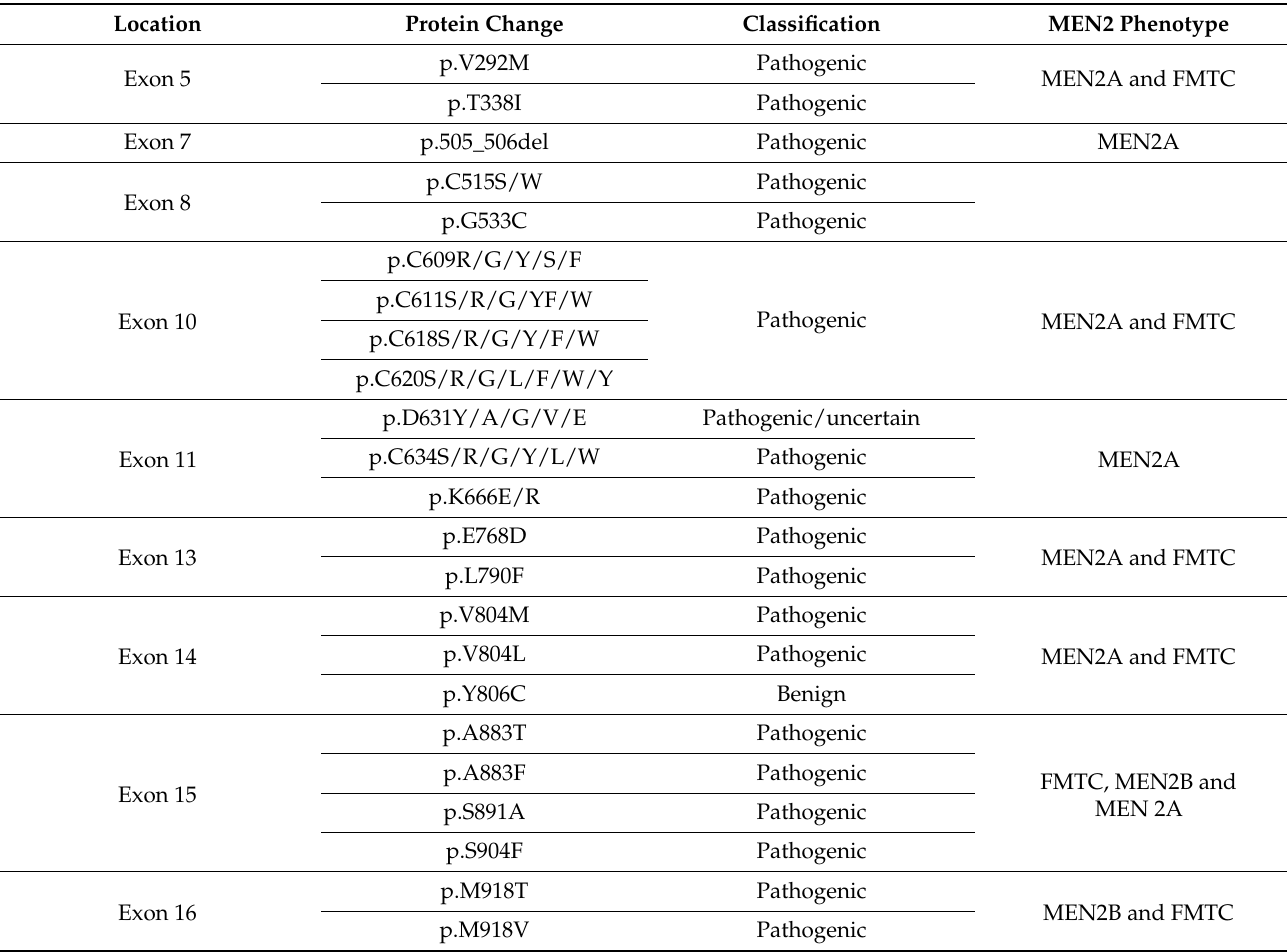
Table 3. Distribution of germline RET mutation in hereditary medullary thyroid carcinoma (MTC).